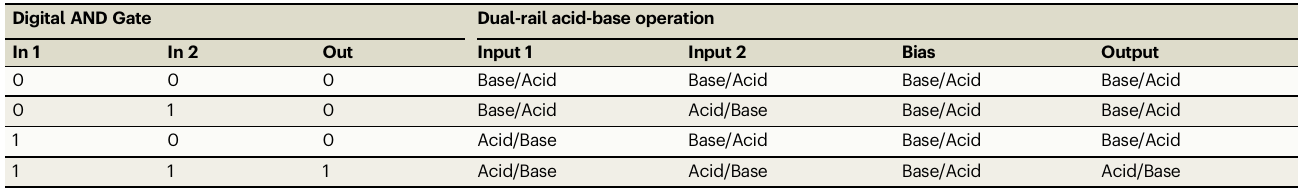
Table 1 | The truth table for the AND gate in digital systems and its corresponding representation in our dual-rail acid- base method Digital AND Gate